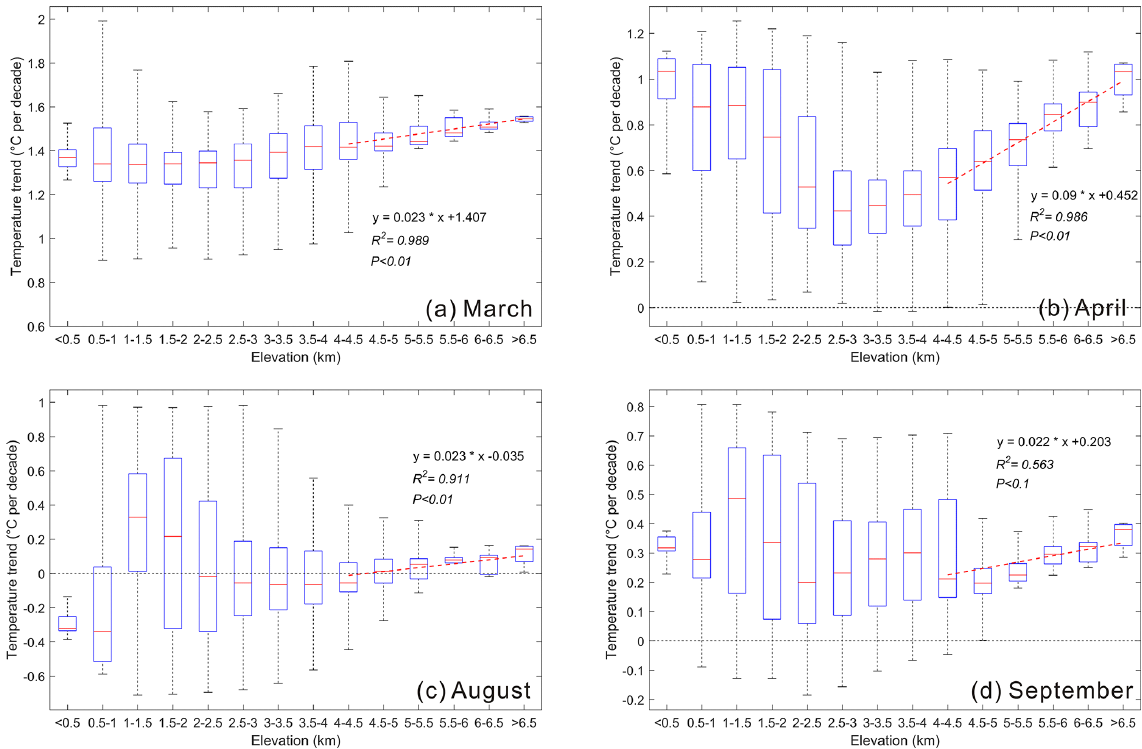
Figure 4. Box plots of monthly maximum temperature trends at different altitudes from 1979 to 2016. (a) March, (b) April, (c) August and (d) September. Thick horizontal lines in boxes show the median values. Boxes indicate the inner-quartile (25% to 75%), and the whiskers show the full range of the values. The red dashed lines represent the significance of EDW by fitting the temperature trends and altitude groups above